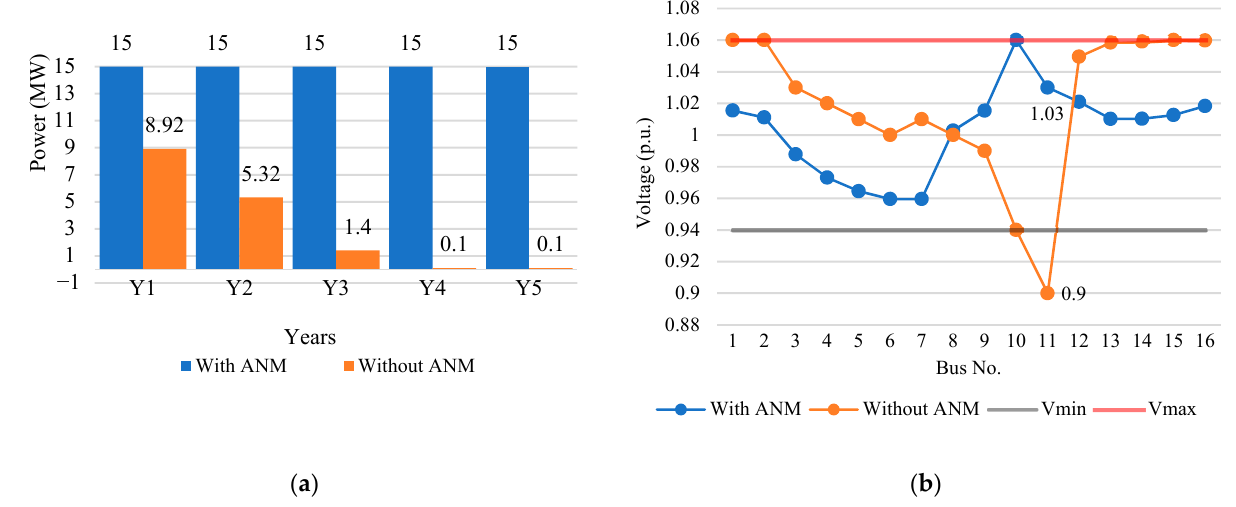
Figure 5. Scenario S3, year Y5: Comparison of network planning with and without ANM. ( a ) Power generated by DG16, ( b ) voltage at each bus.